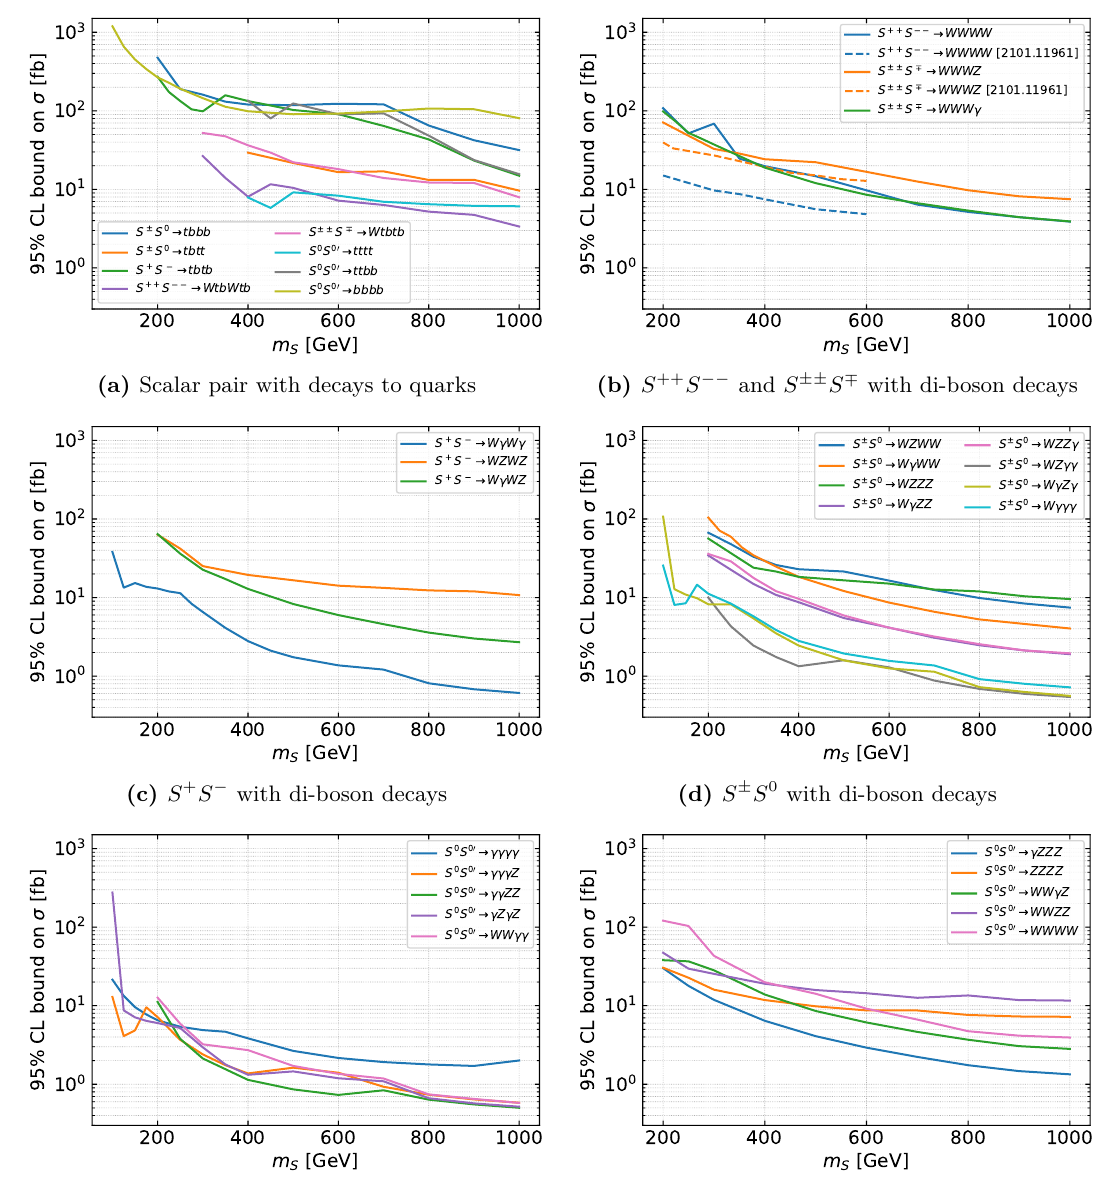
Figure 2. Upper limits on the cross section of the di-scalar channels from Drell-Yan pair produc- tion. The scalars decay to: (a) third generation quarks or (b)-(f) two vector bosons. Both scalars are assumed to have the same mass. The analyses contributing to the bounds are refs. [68–83]